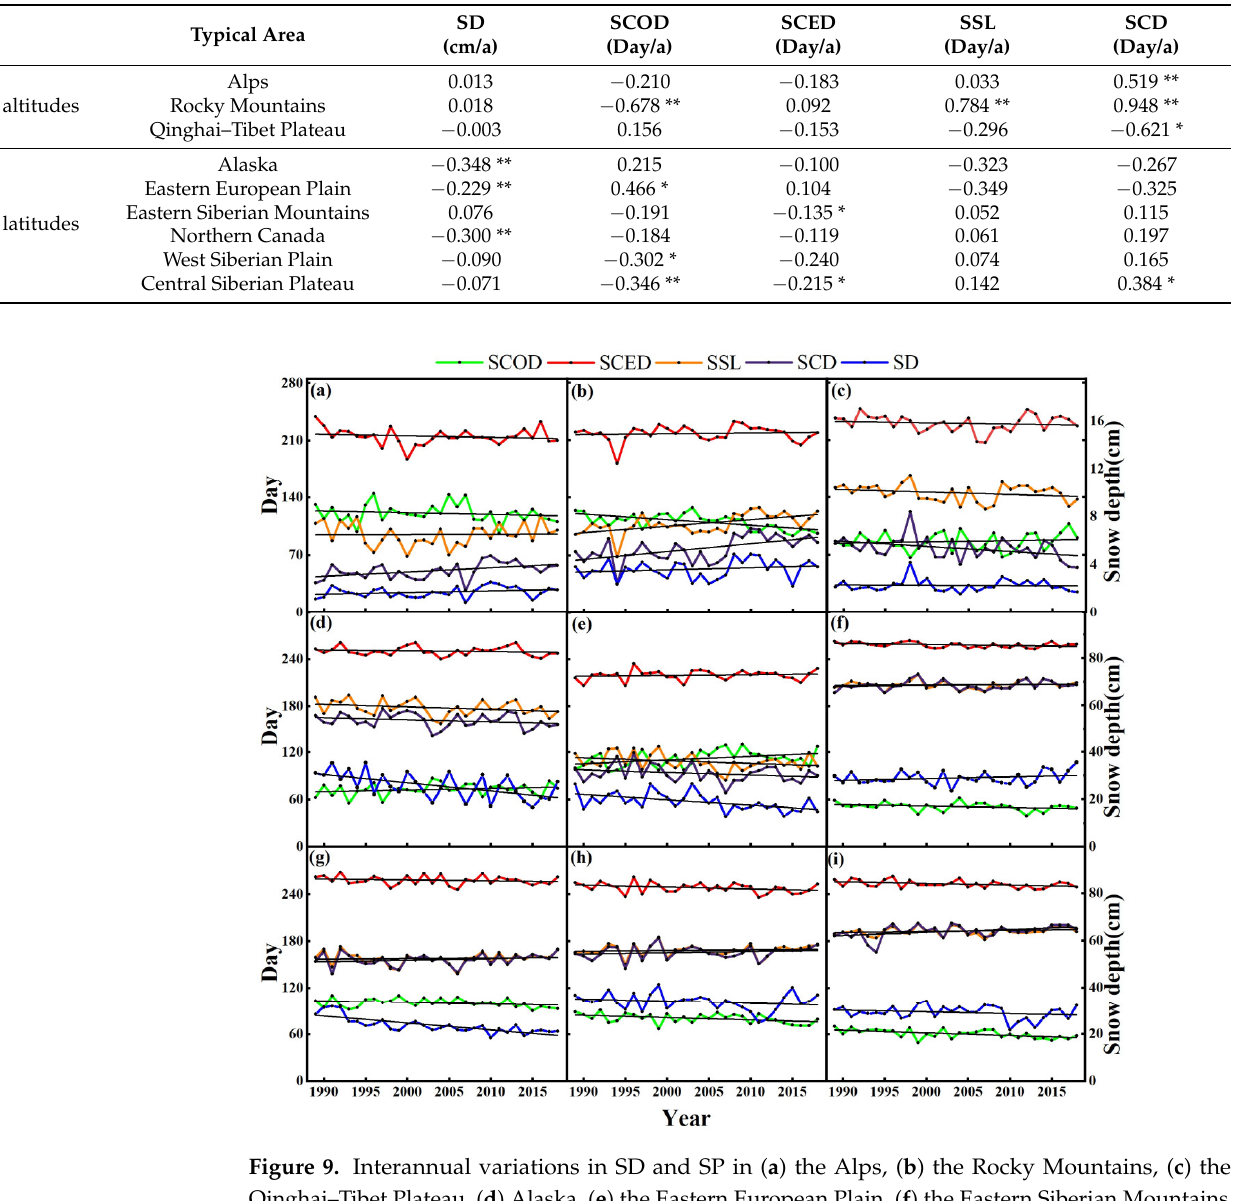
Table 2. SD and SP changes among different typical areas. * and ** indicate that the correlation were significant at the 95% and 99% confidence level, respectively.